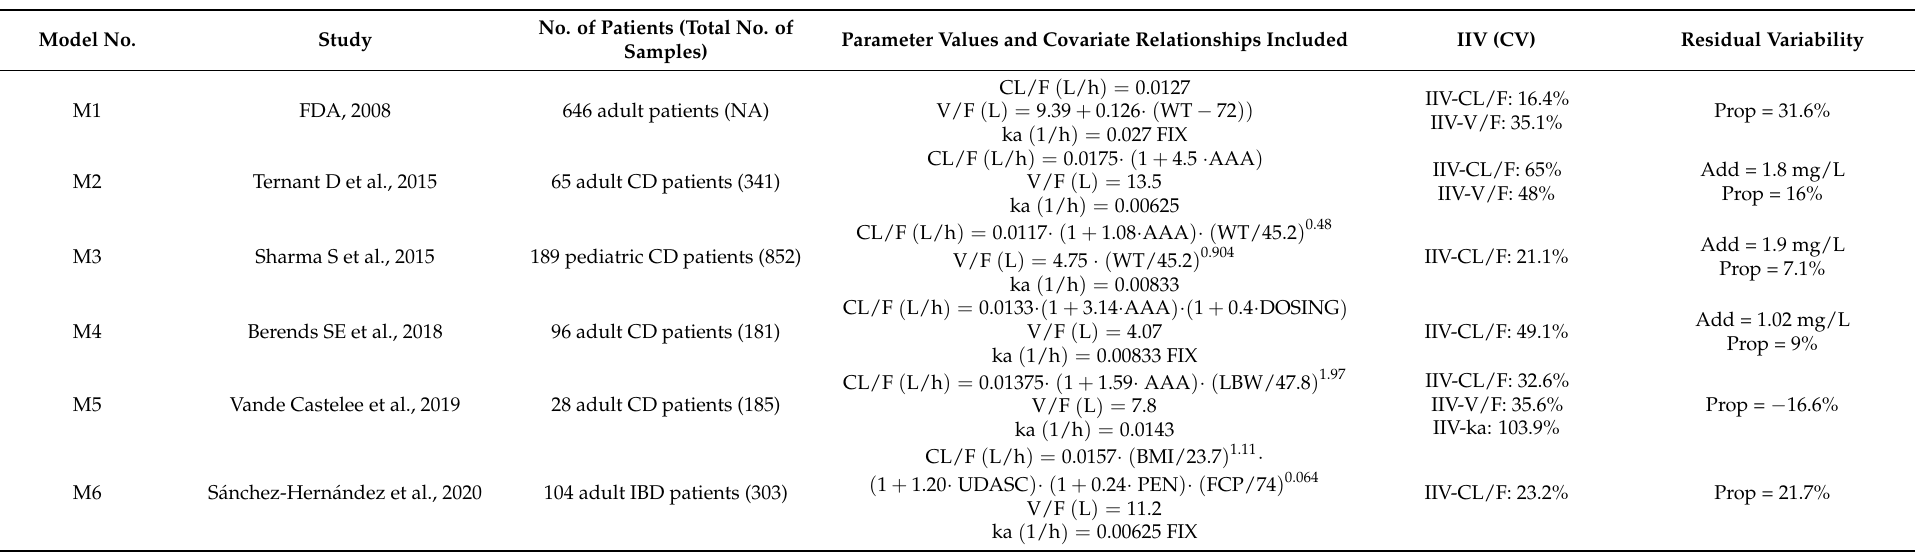
Table 1. Summary of specifications of selected